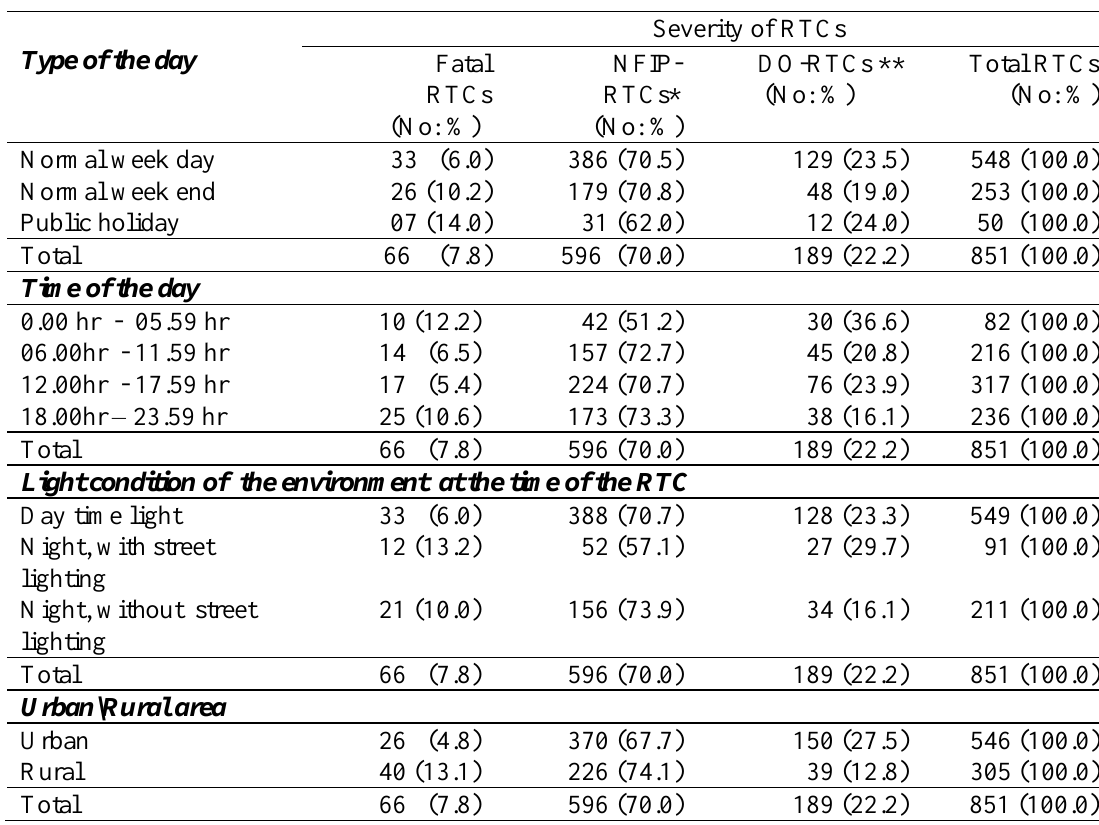
Table 1: Distribution of the severity of RTCs by the environmental